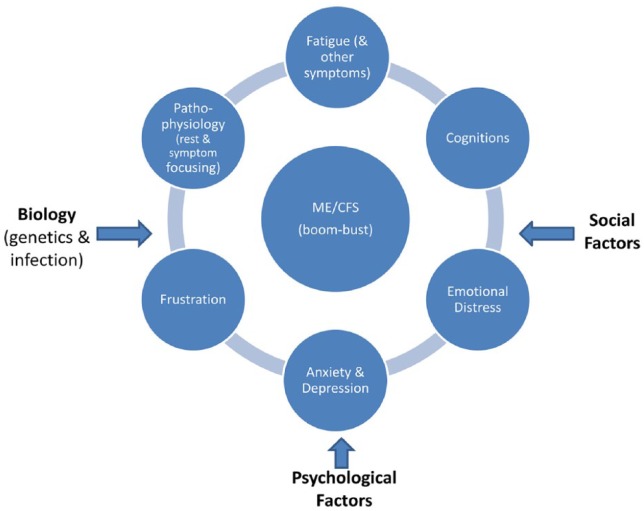
The CBM of ME/CFS.